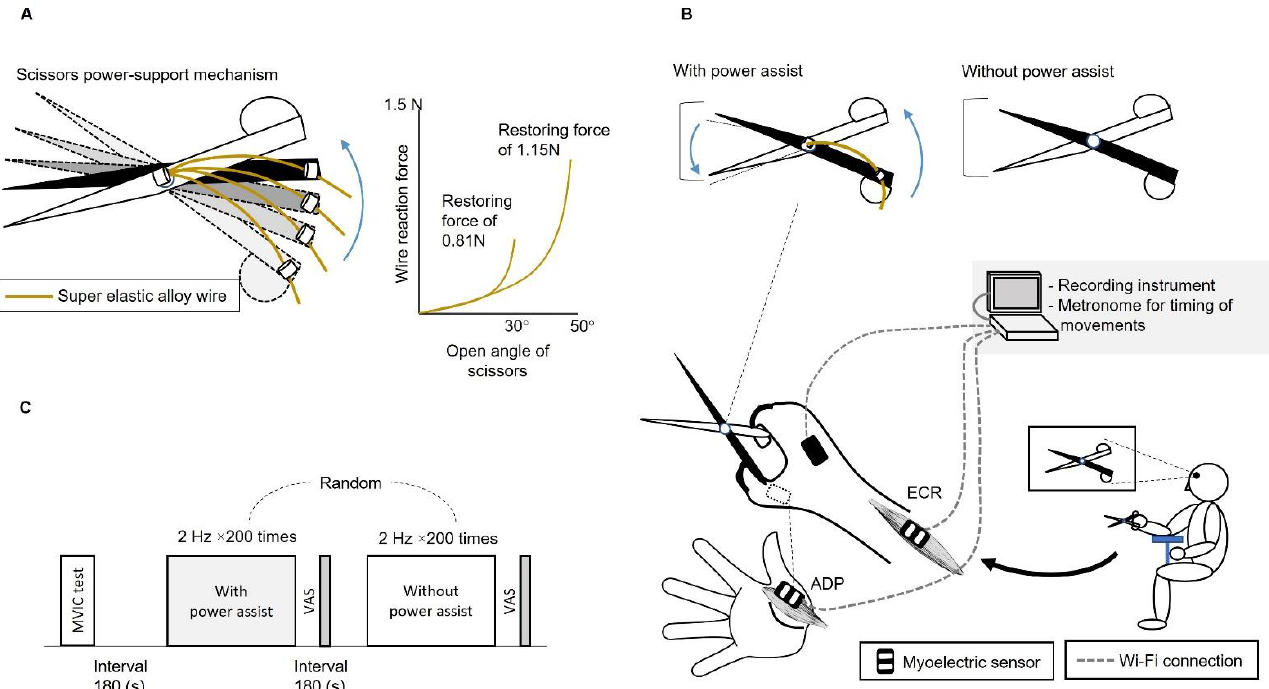
Figure 2. The developed mechanism of the scissors with a power-support device, and the protocol of the experiment. ( A ) Model diagram of the power-support mechanism of the scissors with power-support device. ( B ) Surface electromyogram (sEMG) data acquisition method. The myoelectric sensor was placed on the extensor carpi radialis (ECR) and adductor pollicis (ADP) muscles of the right forearm, and the myoelectric potential obtained from the sensor was analyzed. The recording computer and sensor were connected to Wi-Fi, and a metronome sound was outputted to maintain opening and closing timing. ( C ) The experimental procedure. A 180-s break was provided after performing the maximum isometric contraction task, conditions were set using a random table for the presence or absence of assistance, and the subjects asked to perform scissors opening and closing exercises.